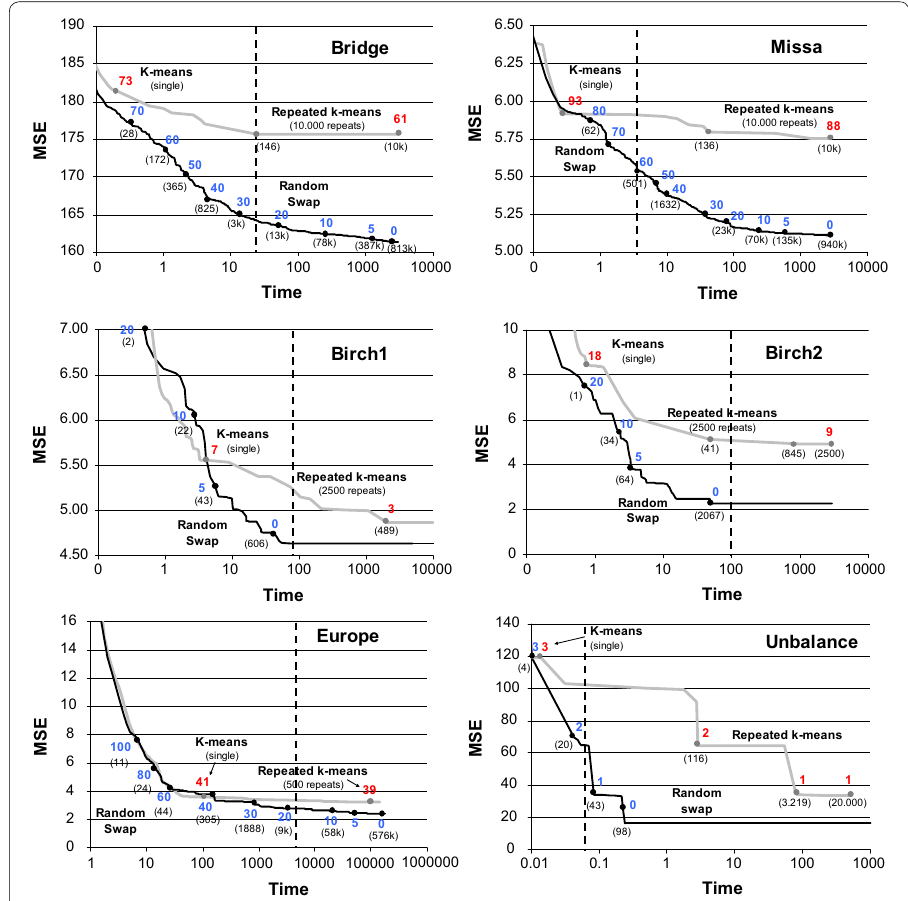
Fig. 16 Time-distortion comparison of random swap and repeated K-means. In parentheses there are number of trial swaps (random swap) or repeats (repeated K-means) applied. The blue and red values show the number of remaining swaps to reach the final solution. Time unit is seconds. The dashed vertical line shows the expected number of